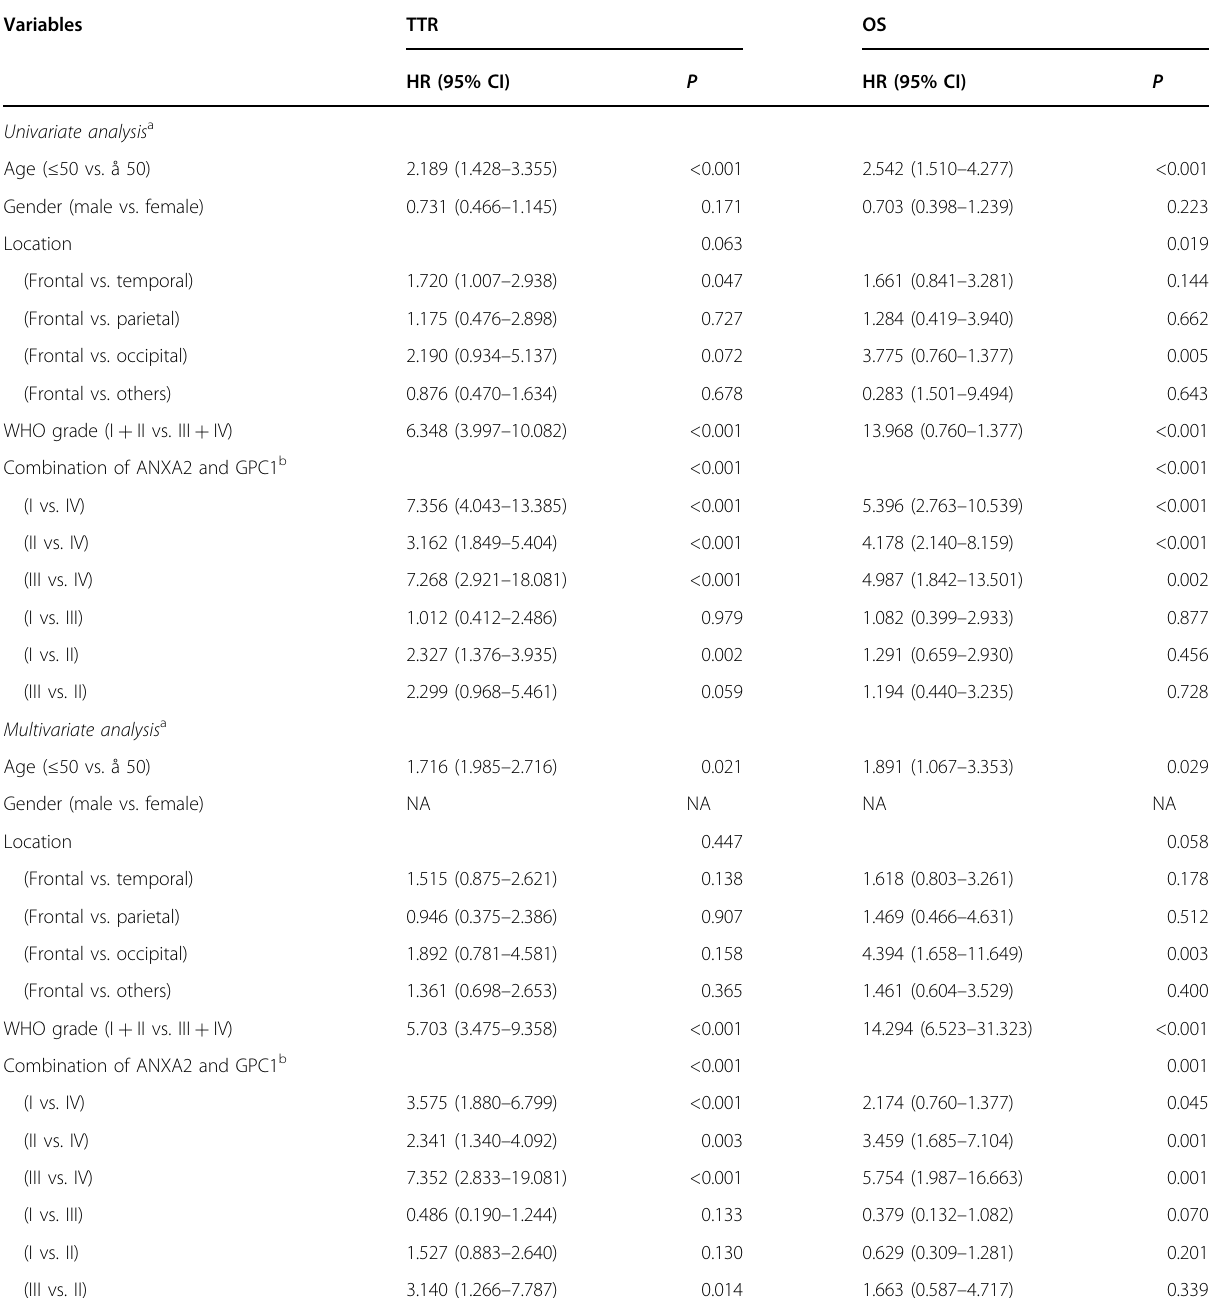
Table 2 Univariate and multivariate analyses of prognostic factors with TTR and OS in glioma ( n = 164). Variables TTR OS HR (95%